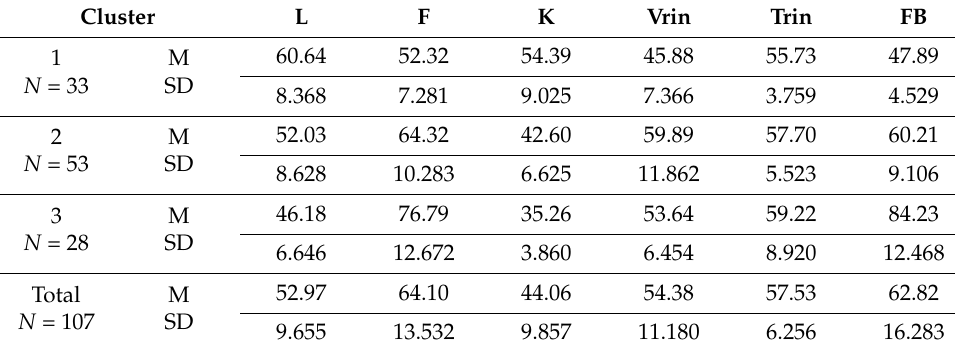
Table 9. Validity scales for the three clusters.